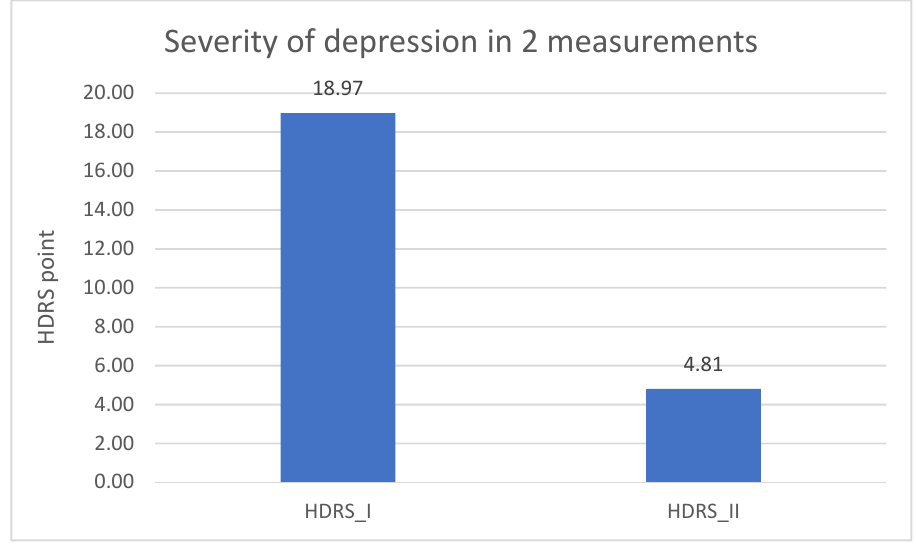
Figure 6. Severity of depression in the experimental group—1 and 2 measurement.